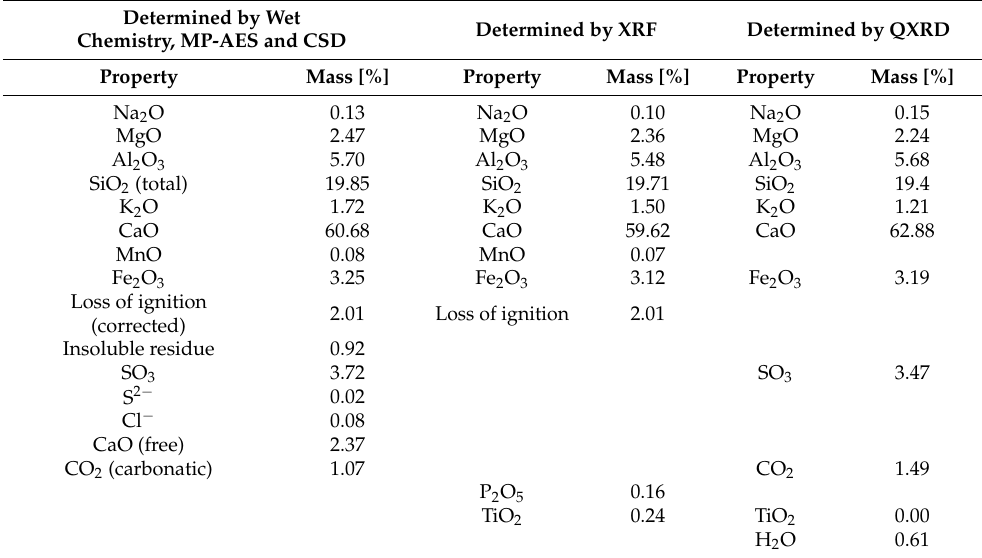
Table 1. Physical properties and mineralogical composition of the employed CEM I 42.5 R